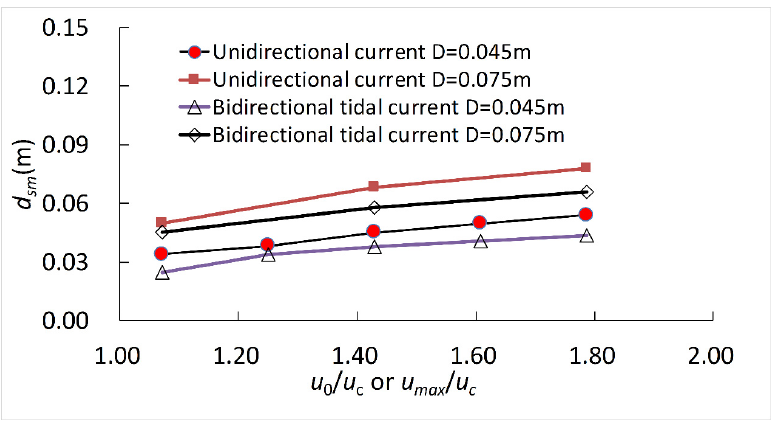
Figure 9. Dimensional maximum scour depth under different flow conditions.